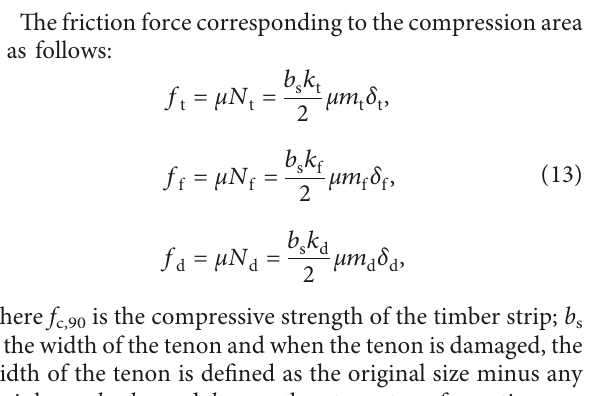
Figure 6: Deformation and stress distribution in local compression zones of the tenon. (a) Local compression deformation distribution and (b) local compression stress